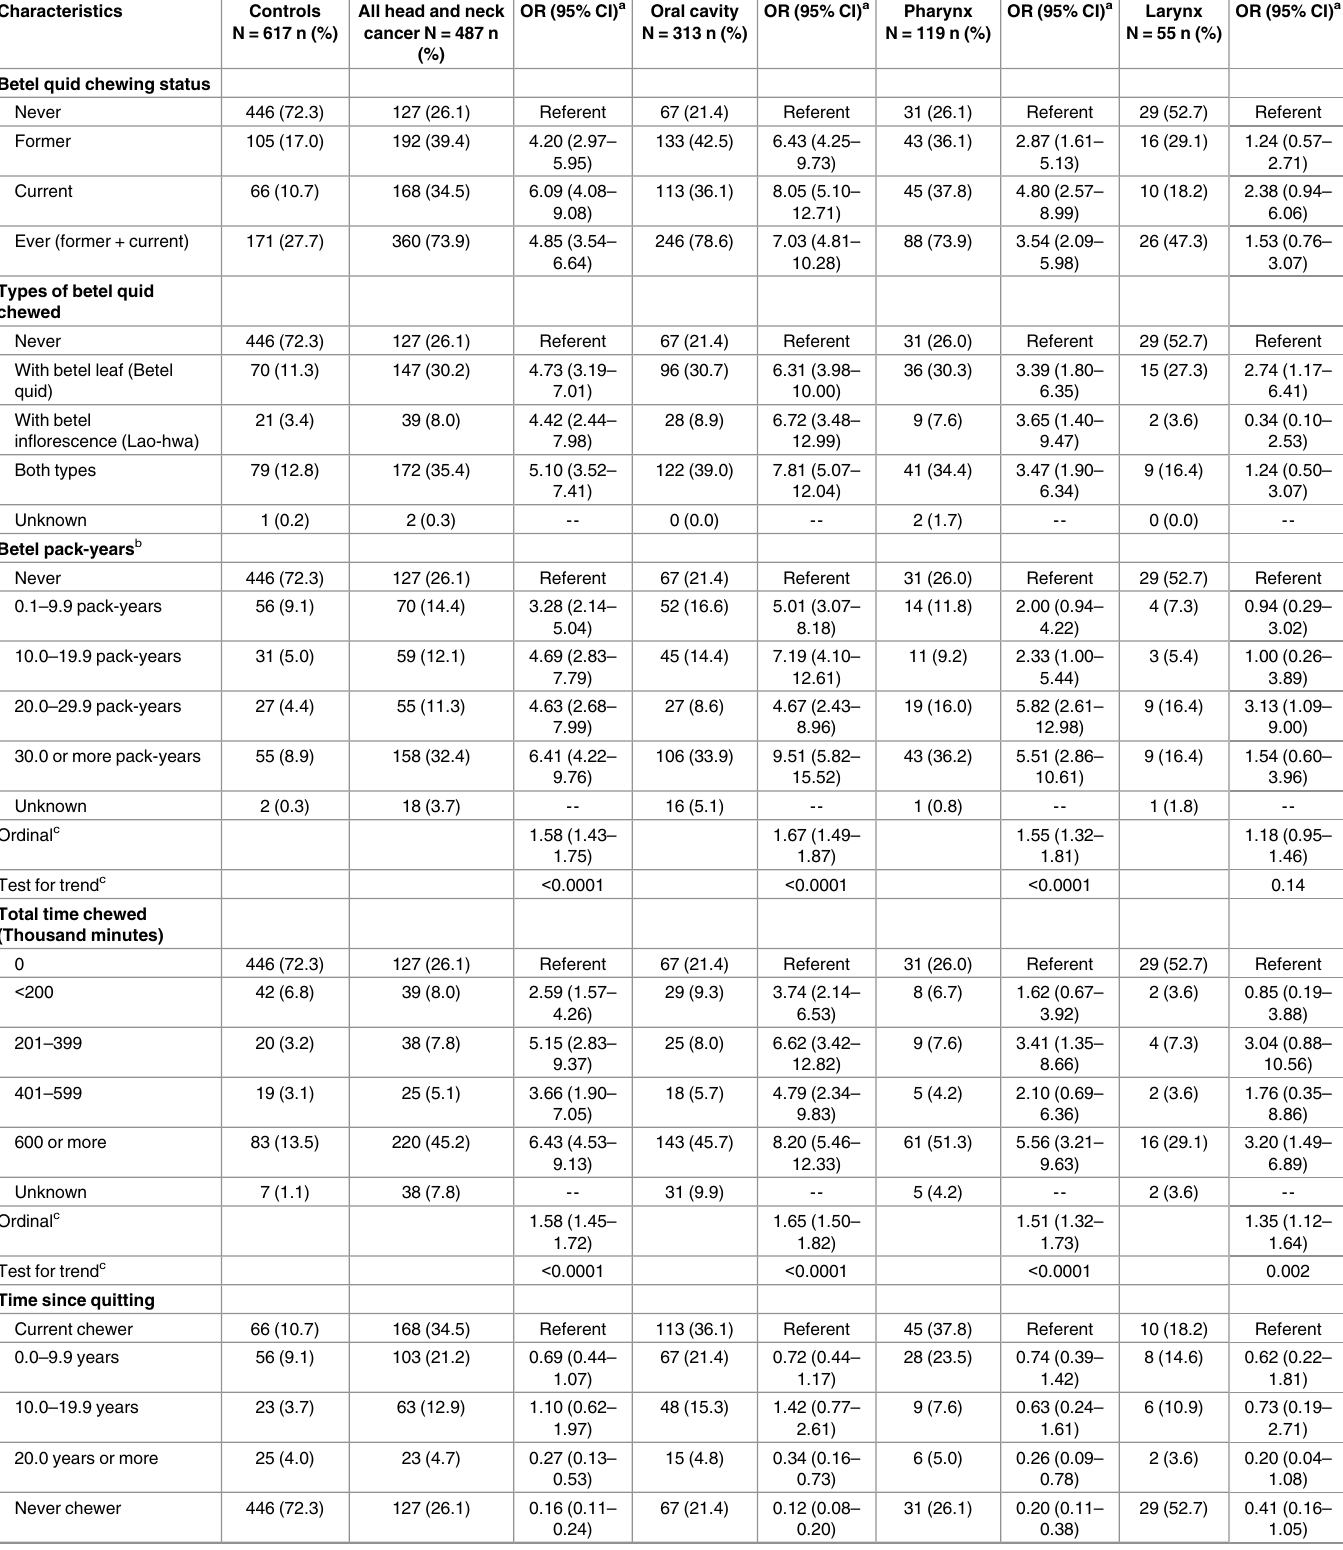
Table 2. The association between betel quid use and risk of head and neck cancer overall and by sites.